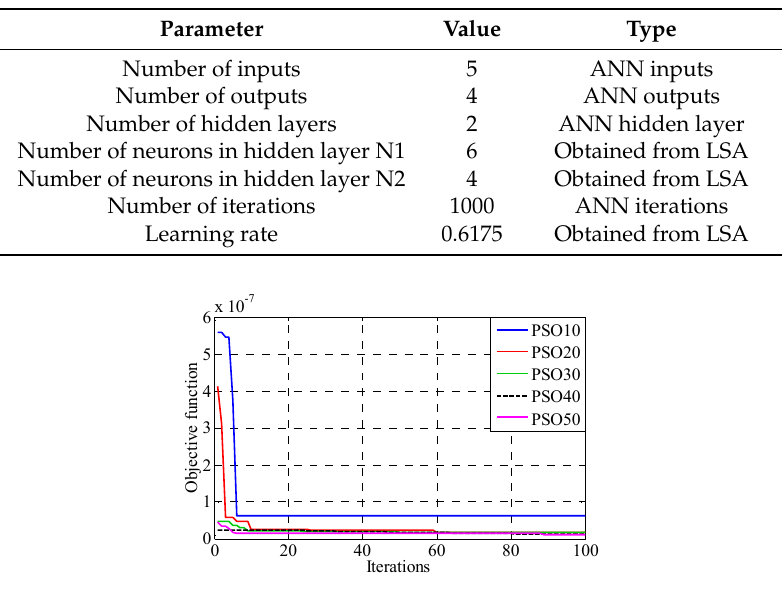
Figure 23. Objective function with iteration of the hybrid particle swarm optimization (PSO)-ANN for different population sizes.